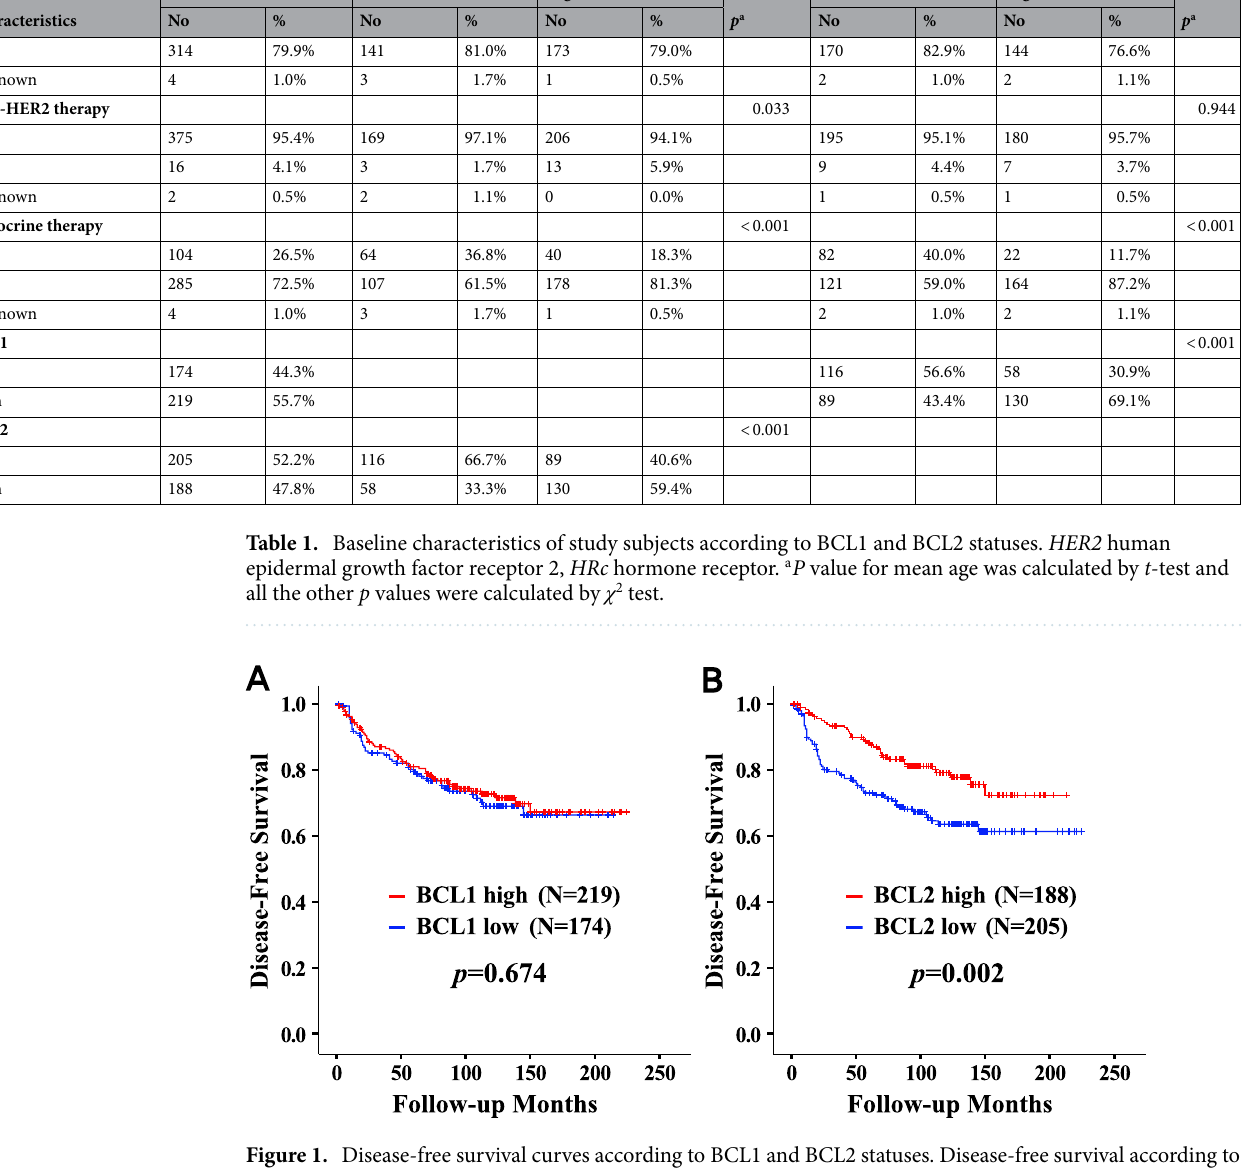
Figure 1. Disease-free survival curves according to BCL1 and BCL2 statuses. Disease-free survival according to BCL1 status ( A ) and BCL2 status ( B